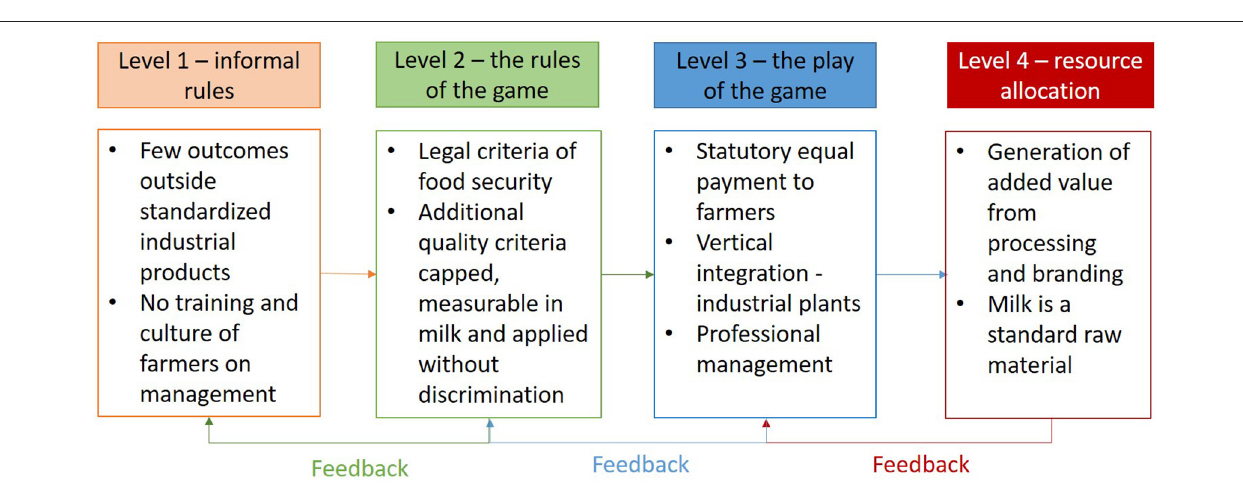
FIGURE 4 | Representation of the coherence of the mainstream cooperative’s model, within Williamson’s